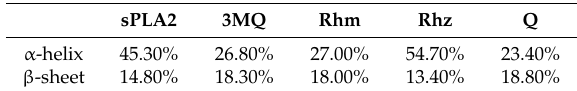
Table 1. Variation of the α -helix and β -sheet percentages in sPLA2 and in the quercetins incubated with the protein. sPLA2 3MQ Rhm Rhz Q α -helix 45.30% 26.80% 27.00% 54.70% 23.40% β -sheet 14.80% 18.30% 18.00% 13.40% 18.80%